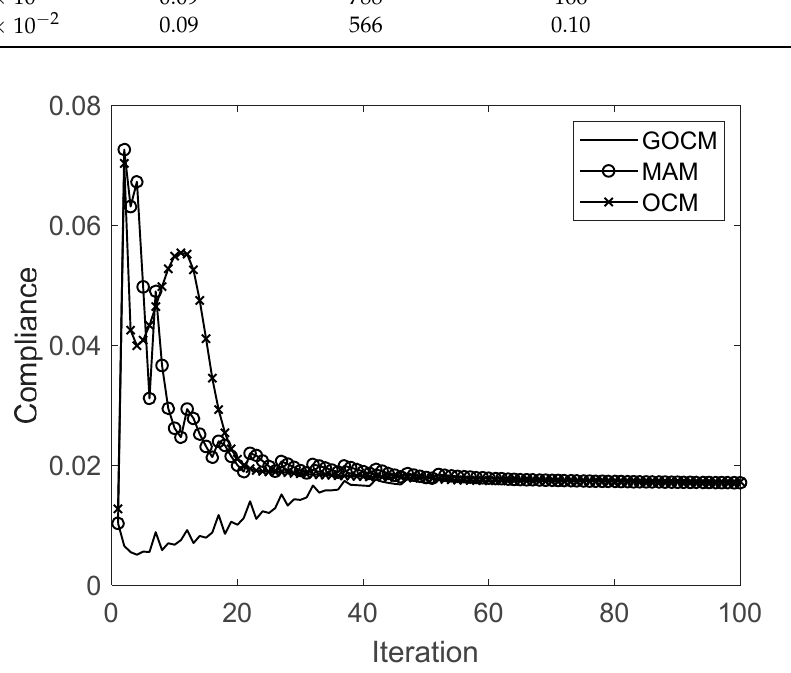
Figure 5. Optimization history of compliance using three optimization algorithms.